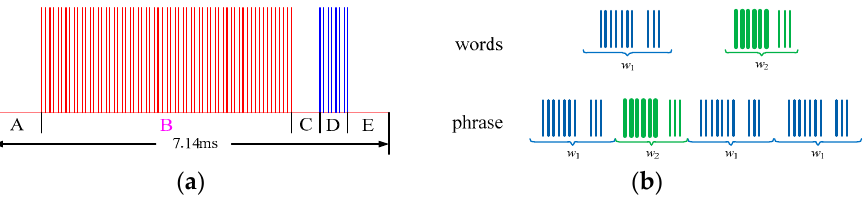
Figure 1. The hierarchical structure of MFR signals. ( a ) A radar word structure of the “Mercury” radar; and ( b ) layered signal structure of a hierarchical MFR example.